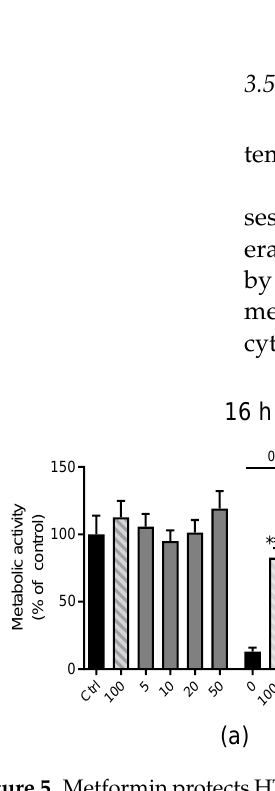
Figure 5. Metformin protects HT22 cells against oxidative damage. ( a ) Metabolic activity was evaluated in erastin-challenged HT22 cells by measuring MTT formazan absorbance (0.3 µ M, 16 h). Eight replicate wells per condition are displayed as mean + SD. The absorbance under control conditions is set as 100%. ( b ) Cell death was assessed by flow cytometry using Annexin V and PI after 16 h of treatment in HT22 cells. The bar graph shows one representative experiment with three replicates per sample (mean + SD; 5000 cells per replicate). ( a , b ) *** p < 0.001, ** p < 0.01 compared to erastin treated control (ANOVA, Scheffé ’ s test) .